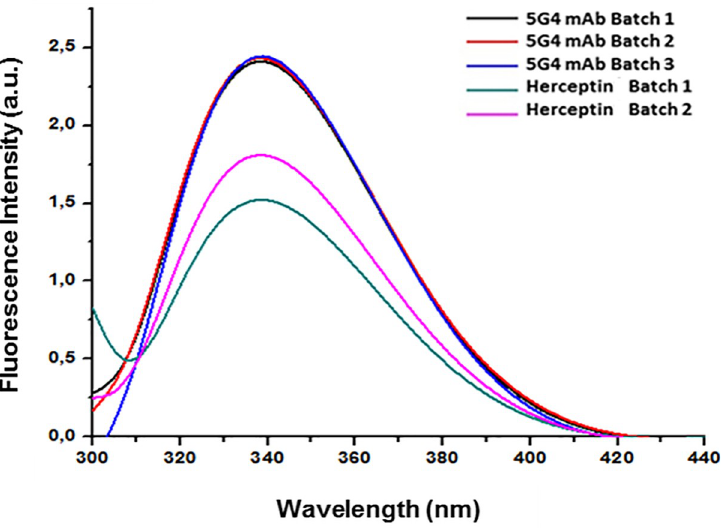
Fig 6. Fluorescence emission spectra for 5G4 mAb and Herceptin in PBS solution. Different batches of each mAb are shown. 5G4 mAb batch 1 (black), 5G4 mAb batch 2 (red), 5G4 mAb batch 3 (blue), Herceptin batch 1 (green) and Herceptin batch 2